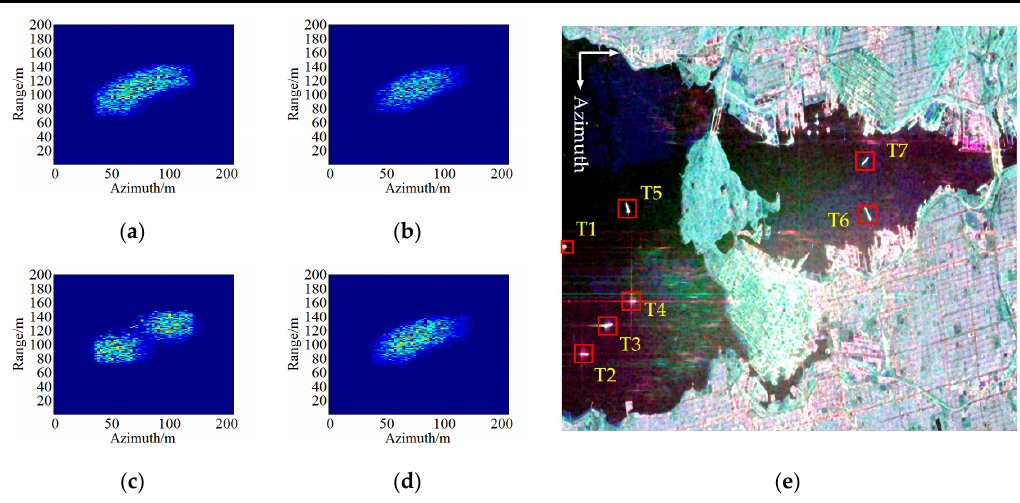
Figure 4. Simulated and real polarimetric radar data of chaff clouds and ships, respectively. ( a – d ) The HH polarization intensity images of chaff clouds for Case 1, Case 2, Case 3-1, and Case 3-2, respectively. ( e ) Pauli color-coded image of Radarsat-2 with marked ships.